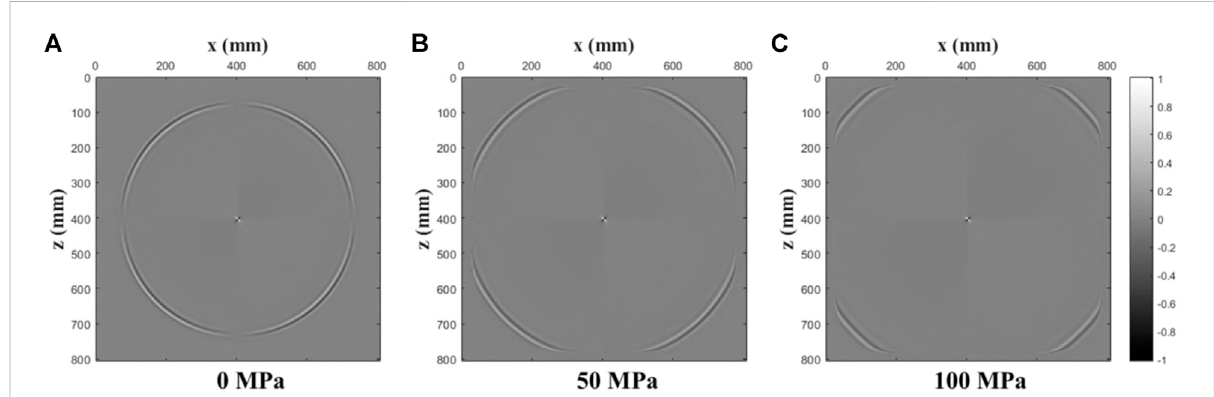
FIGURE 3 Decoupled P-wave fi eld snapshots of the x -component of the particle velocity at t = 0.1 ms for various con fi ning stresses. ( (A) : 0 MPa; (B) : 50 MPa; (C) : 100 MPa).